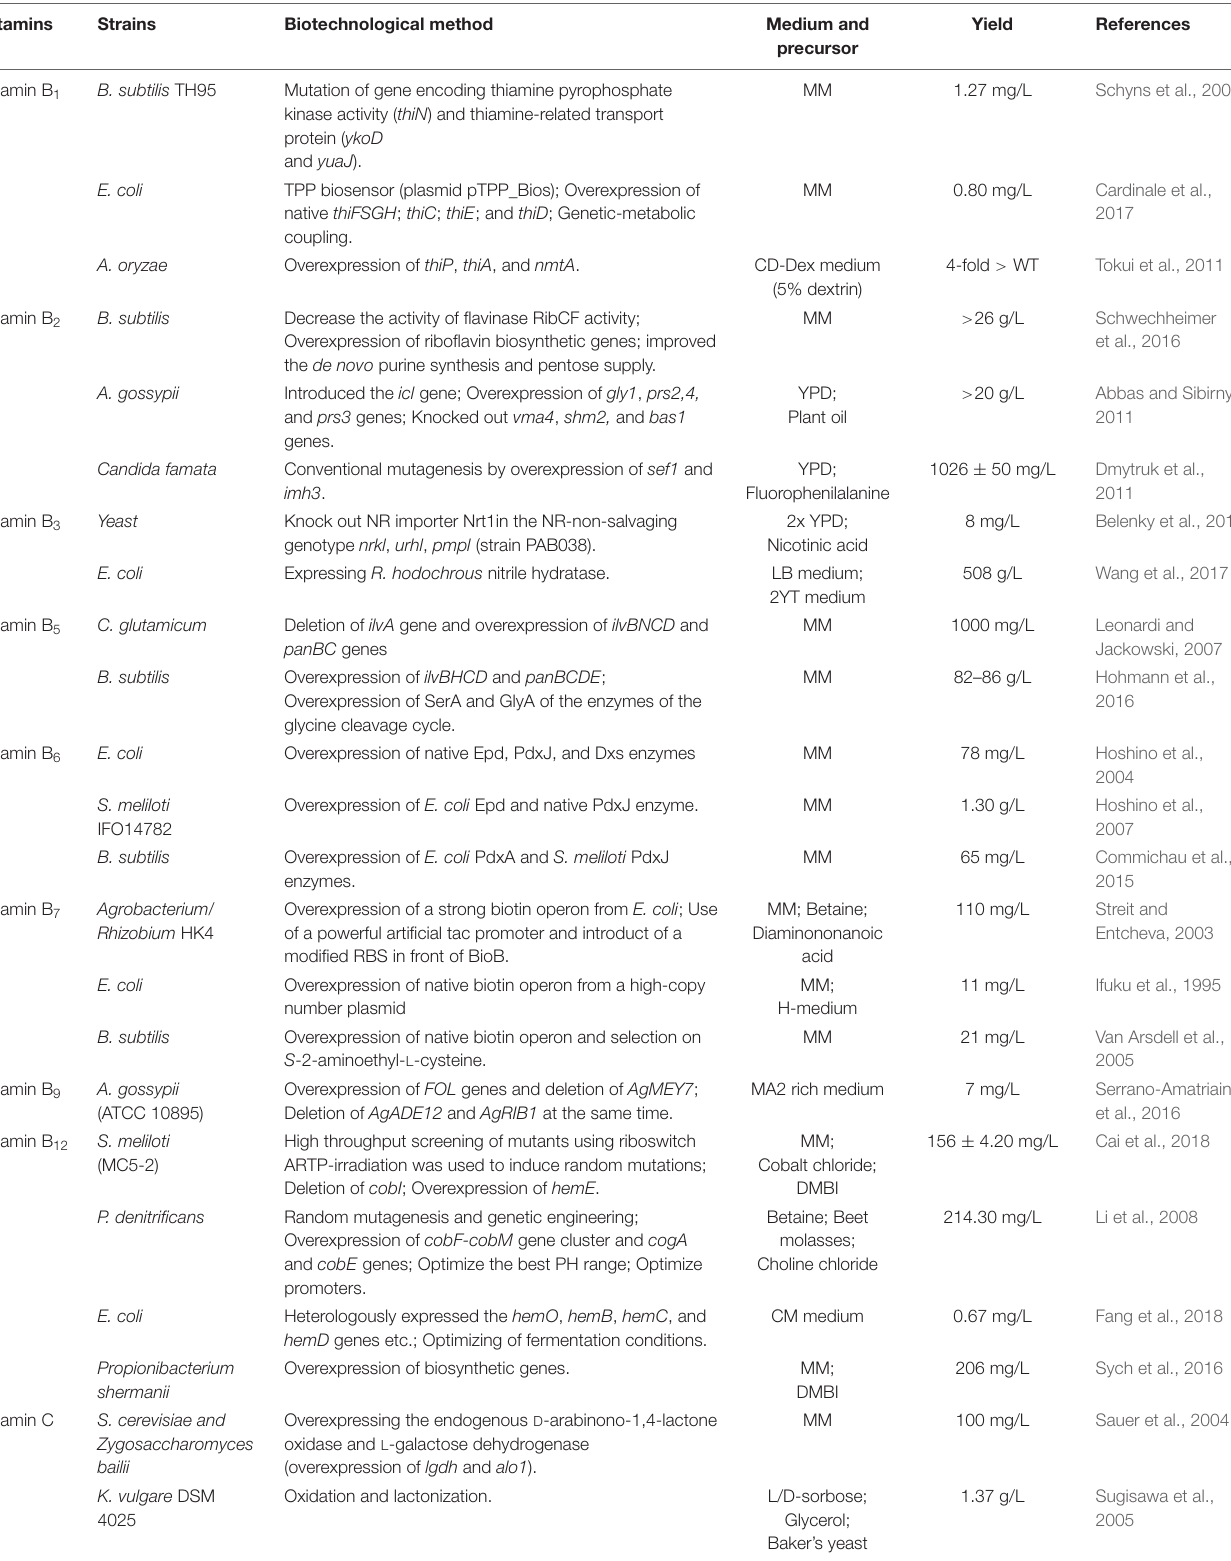
TABLE 1 | Water-soluble vitamins produced by biotechnological methods.